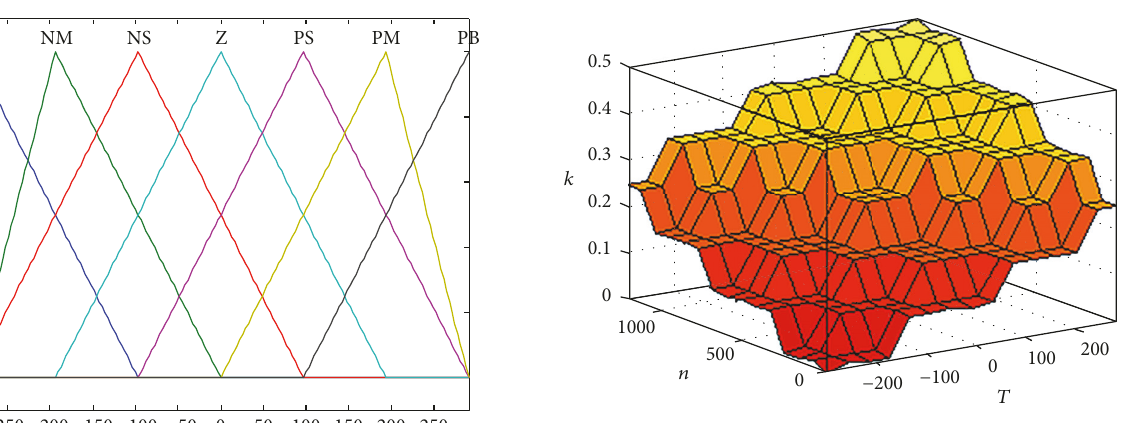
Figure 10: Fuzzy control strategy torque distribution factor. Table 2: The basic parameters of the prototype